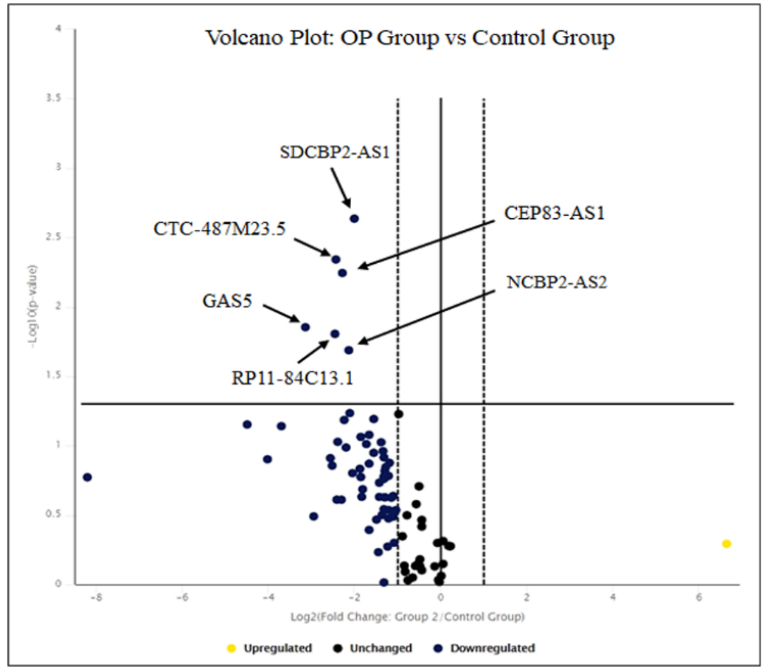
Figure 2. Volcano plot of LncRNAs levels in OP vs. CTRs. The Volcano plot shows the significant lncRNAs that we found down-regulated in osteoblast cell lines on the left (down-regulated) and above the solid vertical line (statistically significant), according to significant p -value and fold-regulation change. The solid vertical line represents no change in gene expression (log2 (1) = 0). The dotted lines represent a selected threshold or boundary for fold change. The default setting is 2. The solid vertical line represents a selected threshold for the p -value and statistical significance. The default setting is 0.05. Statistical significance versus fold-change is shown on the y- and x-axes, respectively [24].